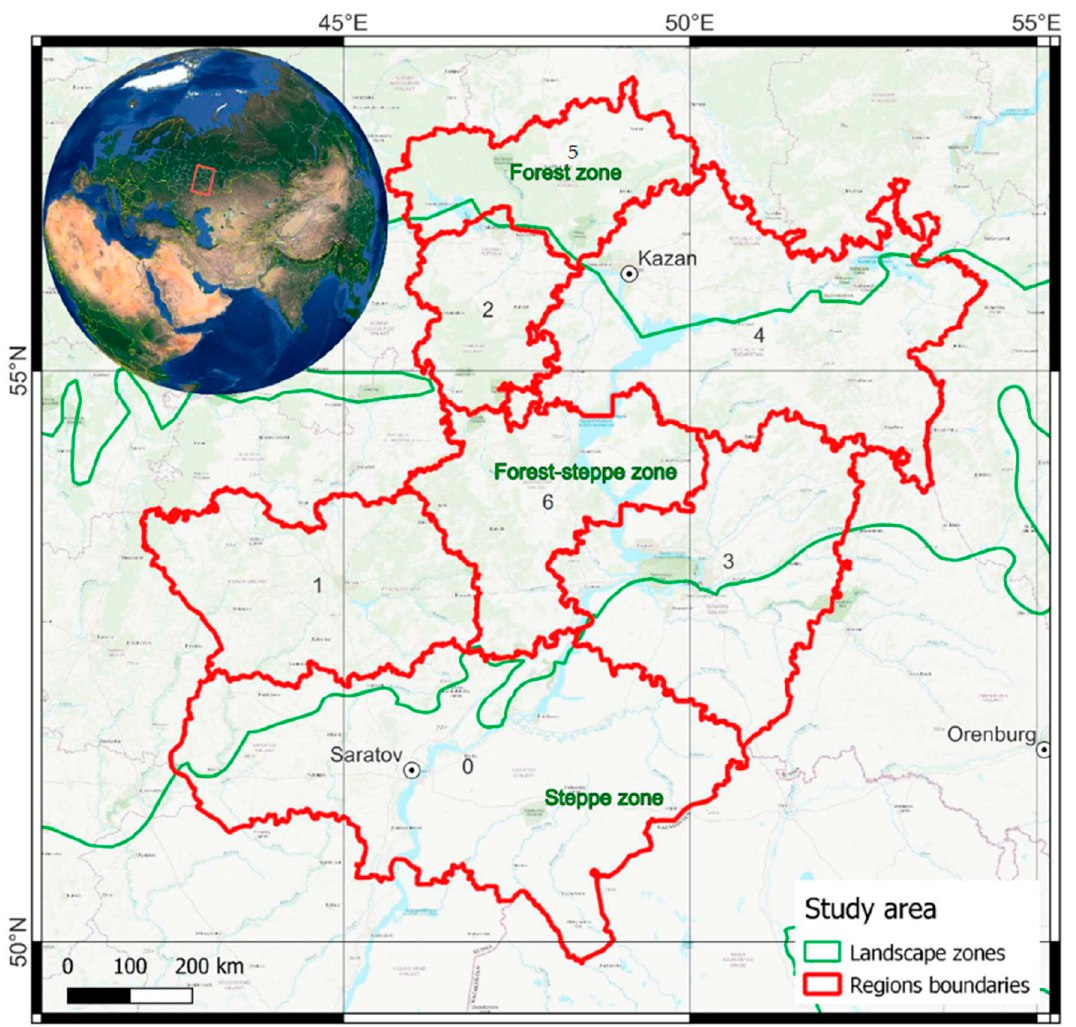
Figure 1. The study area. The 0—Saratov region, 1—Penza region, 2—Republic of Chuvashia, 3—Samara region, 4—Republic of Tatarstan, 5—Republic of Mari El, and 6—Ulyanovsk